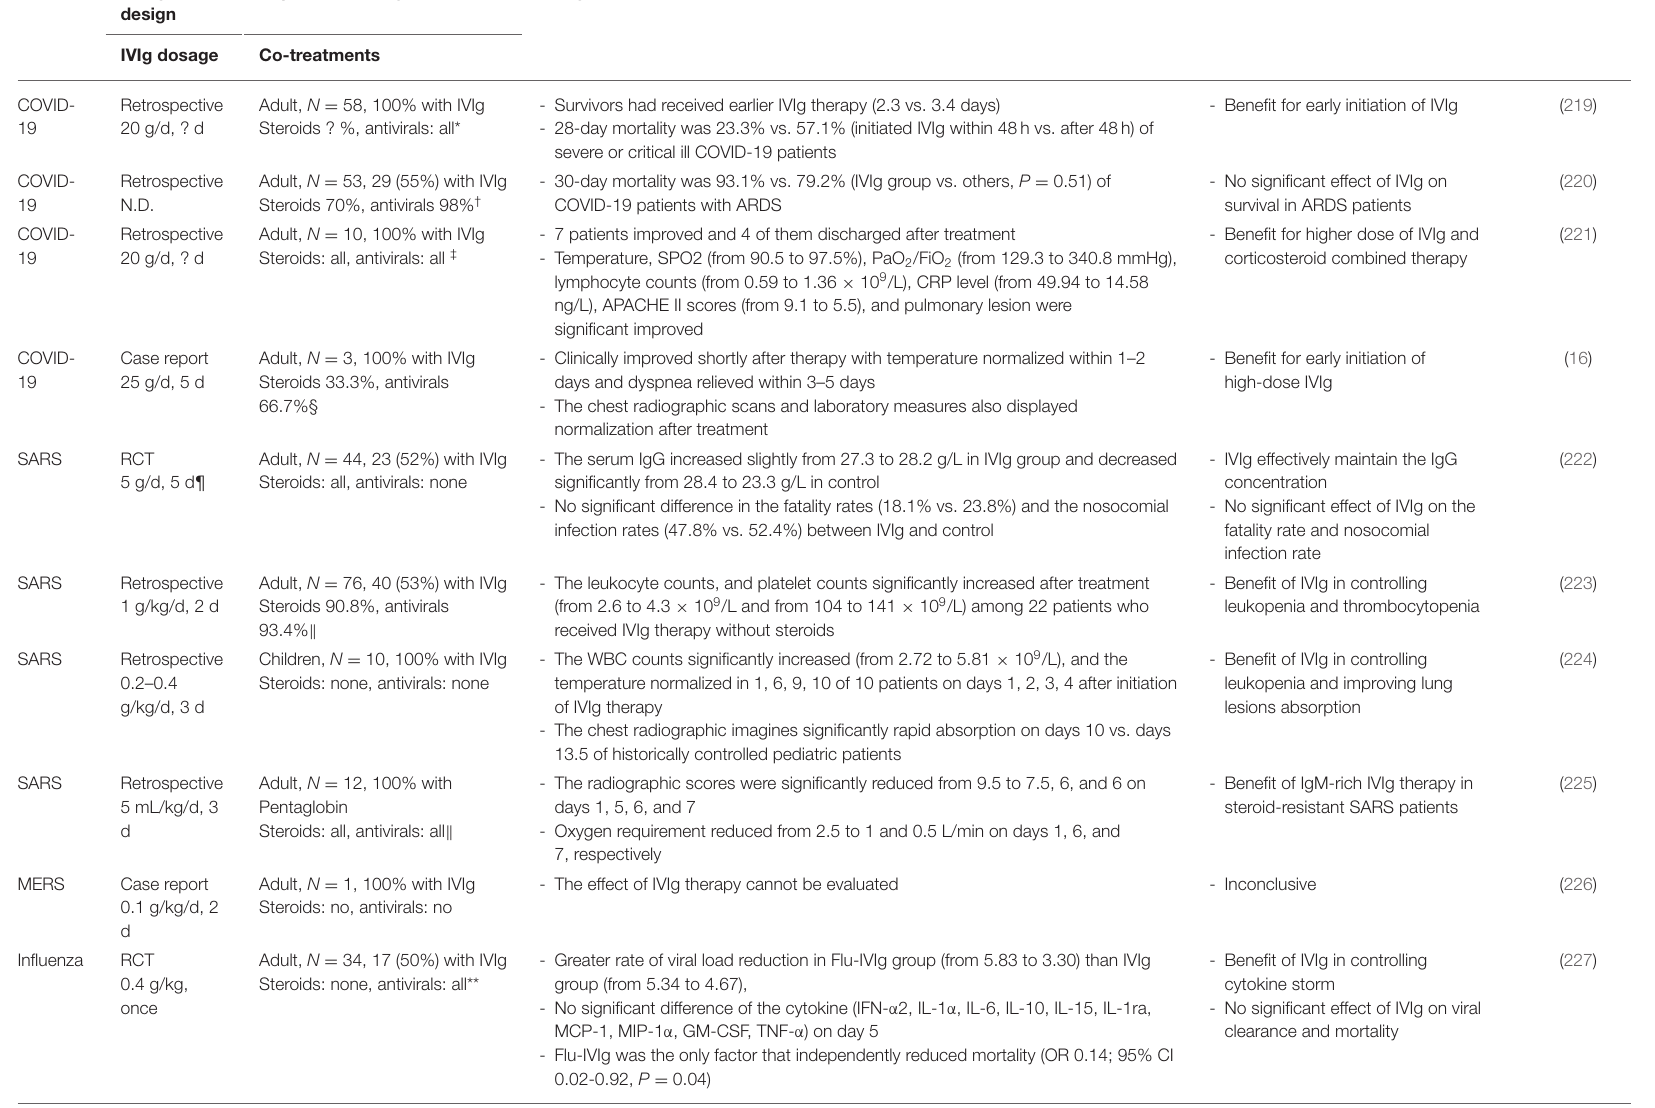
TABLE 2 | Description of studies within IVIg treated severe acute viral pneumonia patients.